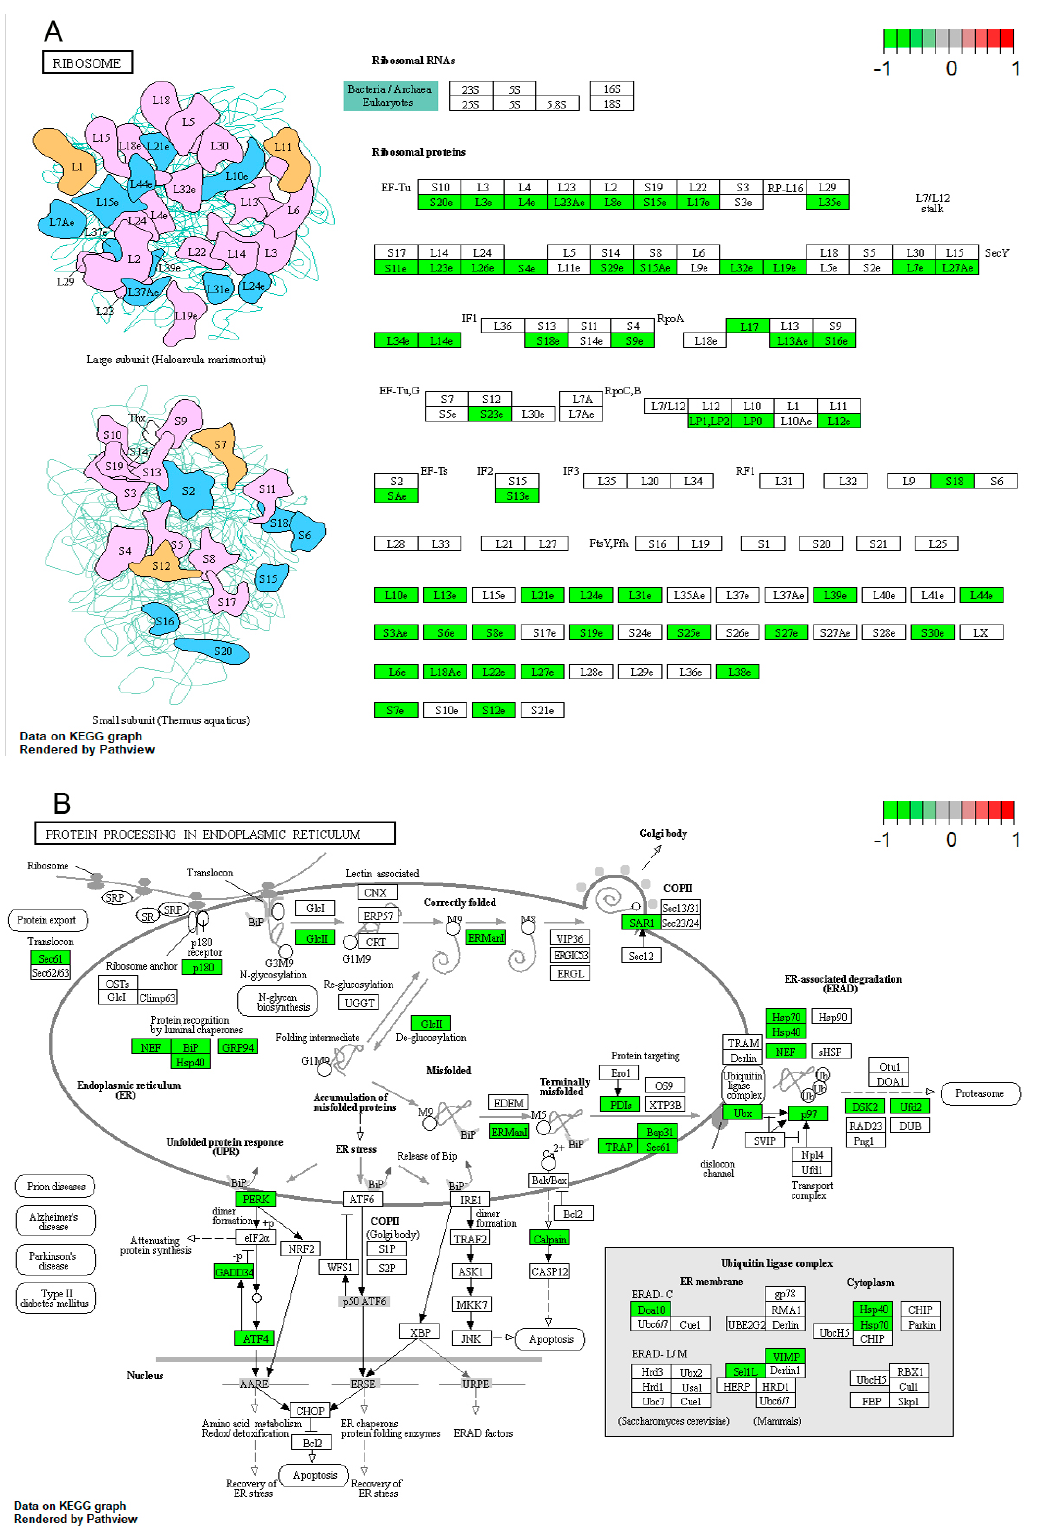
Figure 4. The KEGG pathways of ribosome ( A ) and protein processing in the endoplasmic reticulum ( B ). Genes highlighted in green are enriched and highly expressed in late-dividing SCNT embryos.